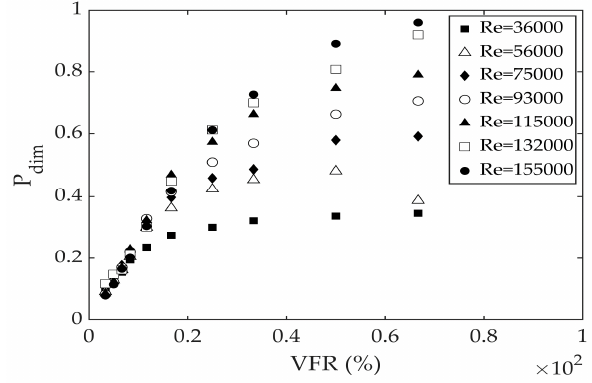
Figure 12. Dimensionless power for different VFR and Re numbers in TI-CAES system.